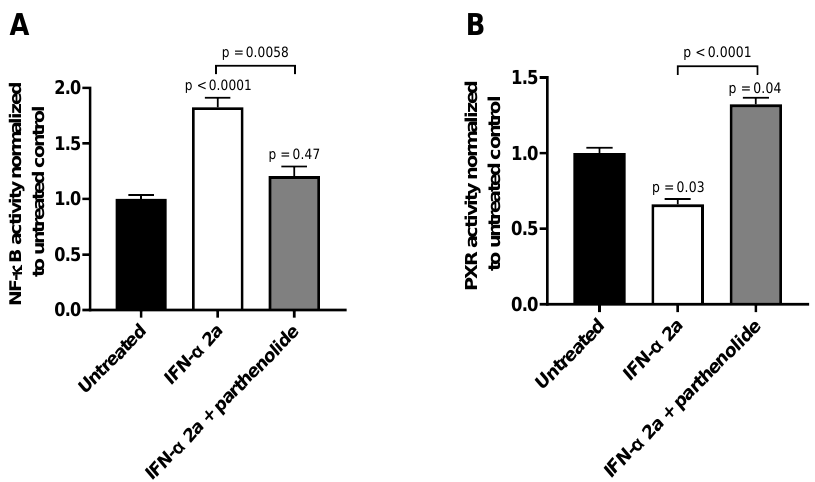
Figure 2. Effect of parthenolide (10 µ M) on IFN- α 2a-mediated activation of NF-kB ( A ) or suppression of PXR ( B ) in LS180 cells after 6 h of exposure to 5000 U/mL of IFN- α 2a. Data shown are the mean ± S.E.M. of three independent experiments with technical quadruplets each. Statistical significance was evaluated using a nonparametric Kruskal–Wallis test and Dunn’s multiple comparison test. Single p values refer to comparison with untreated controls, whereas the p values above line show significance between treatments being connecting by this line. p values < 0.05 were considered